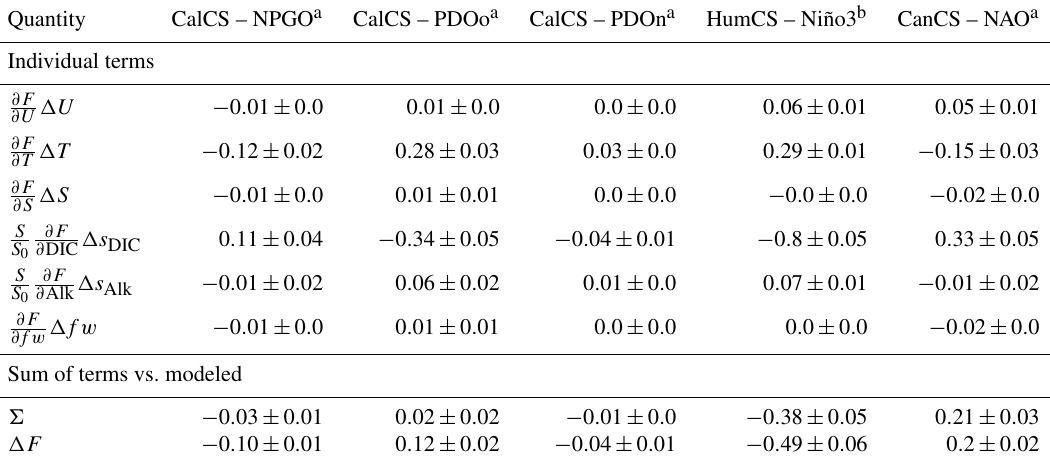
Table 2. Estimated contributions of individual terms to air–sea CO 2 flux anomalies, (cid:49)F , in response to a mode of climate variability using Eq. (4). Each row under “Individual terms” depicts the ensemble mean contribution and ensemble spread for Figs. 6–9. The column “CalCS– PDOn” reflects results from the nearshore box in the CalCS in Fig. 7, and “CalCS–PDOo” reflects results from the offshore box. (cid:54) is the sum of all contributing first-order terms (i.e., all rows under “Individual terms” or the right-hand side of Eq. 4). (cid:49)F is the direct regression of CO 2 flux anomalies on the specified mode of climate variability (i.e., the left-hand side of Eq. 4).